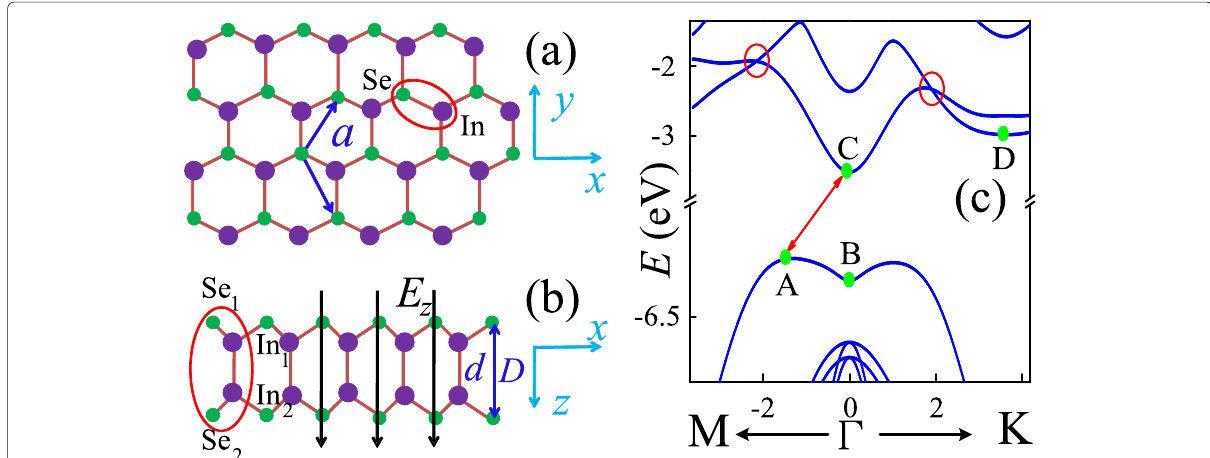
Fig. 1 (Color online) Top ( a ) and side ( b ) view of the monolayer InSe in the xy and xz planes, respectively. The lattice constant between the nearest In or Se ions in the xy plane is a , and the distance between the nearest In (Se) ions in different sublayers is d ( D ). A perpendicular electric field along z -axis E z is applied to the monolayer InSe. c Energy band of monolayer